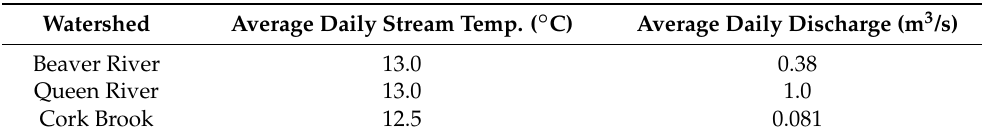
Table 5. The average stream temperature simulated by SWAT 1980–2009.